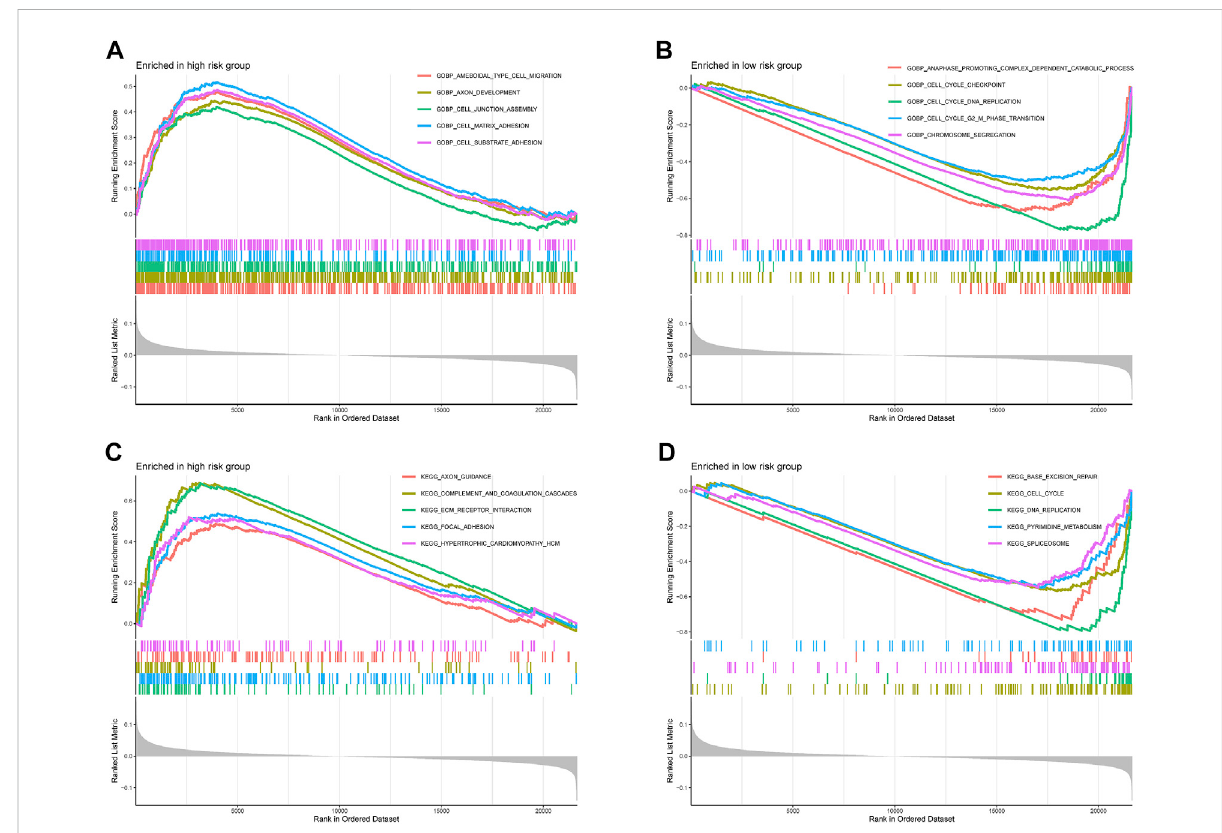
FIGURE 10 Functionalenrichmentanalyses. (A,B) GeneOntologyand (C,D) KyotoEncyclopediaofGenesandGenomespathwaysenrichedbetweenhigh- risk group and low-risk group in the TCGA-COAD